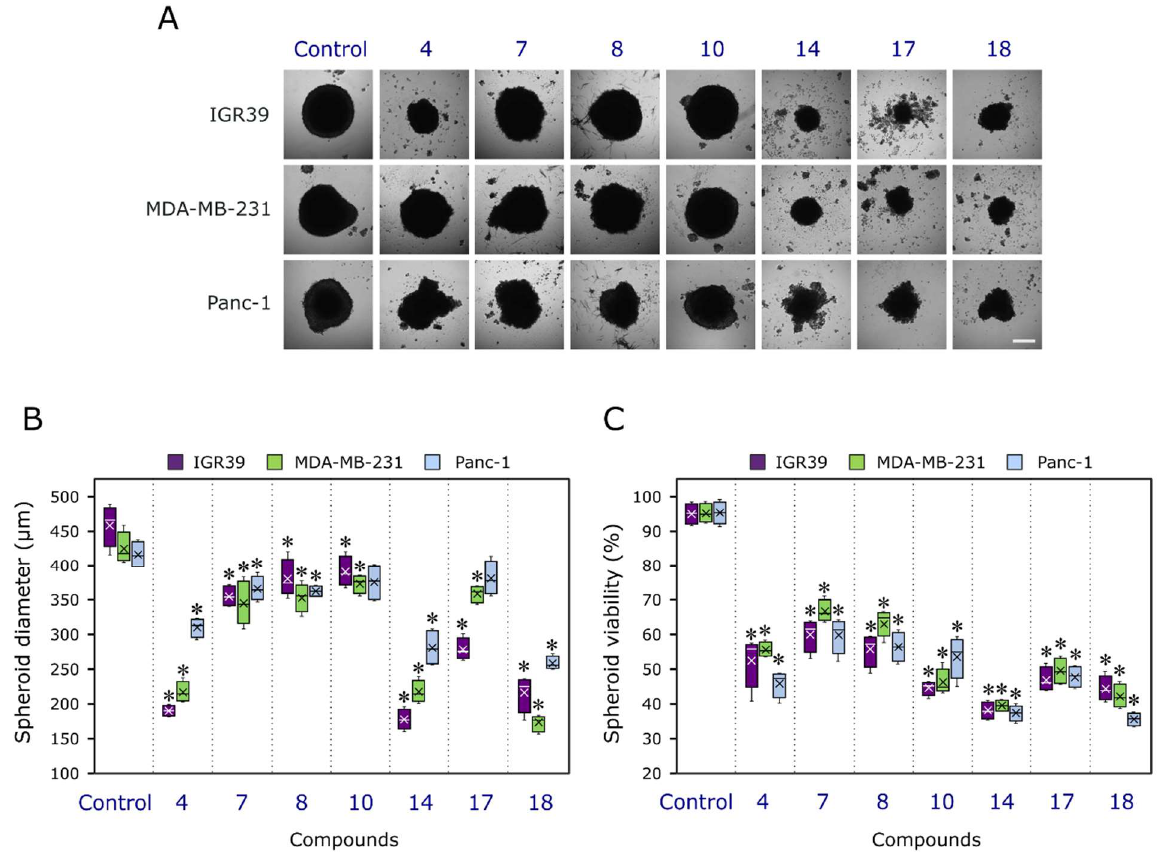
Figure 4. Effect of the most active hydrazones 4 , 7 , 8 , 10 , 14 , 17 , and 18 on 3D cell cultures. ( A ) Photos of human melanoma IGR39, human triple-negative breast cancer MDA-MB-231, and human pan- creatic carcinoma Panc-1 tumour spheroids at the end of the experiment (after 8 days of incubation with 10 µM of compounds). ( B ) Spheroid size at the end of the experiment. ( C ) Cell viability in the IGR39, MDA-MB-231, and Panc-1 spheroids. Asterisks (*) indicate p < 0.05 compared to the control (untreated spheroids), crosses (×) indicate means; inner dashes indicate medians; whiskers indicate maximum and minimum values. Scale bars indicate 200 µm.